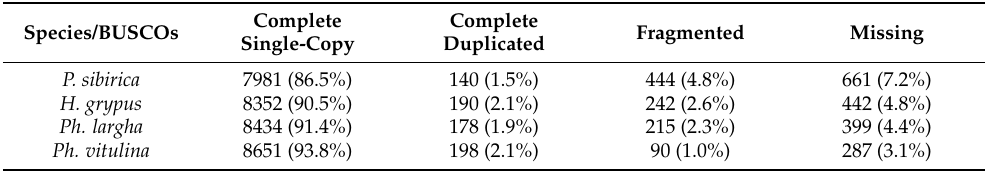
Table 2. Completeness of pinniped genome assemblies assessed using BUSCO v5; the mam- malia_odb10 database of 9226 orthologs was used in the